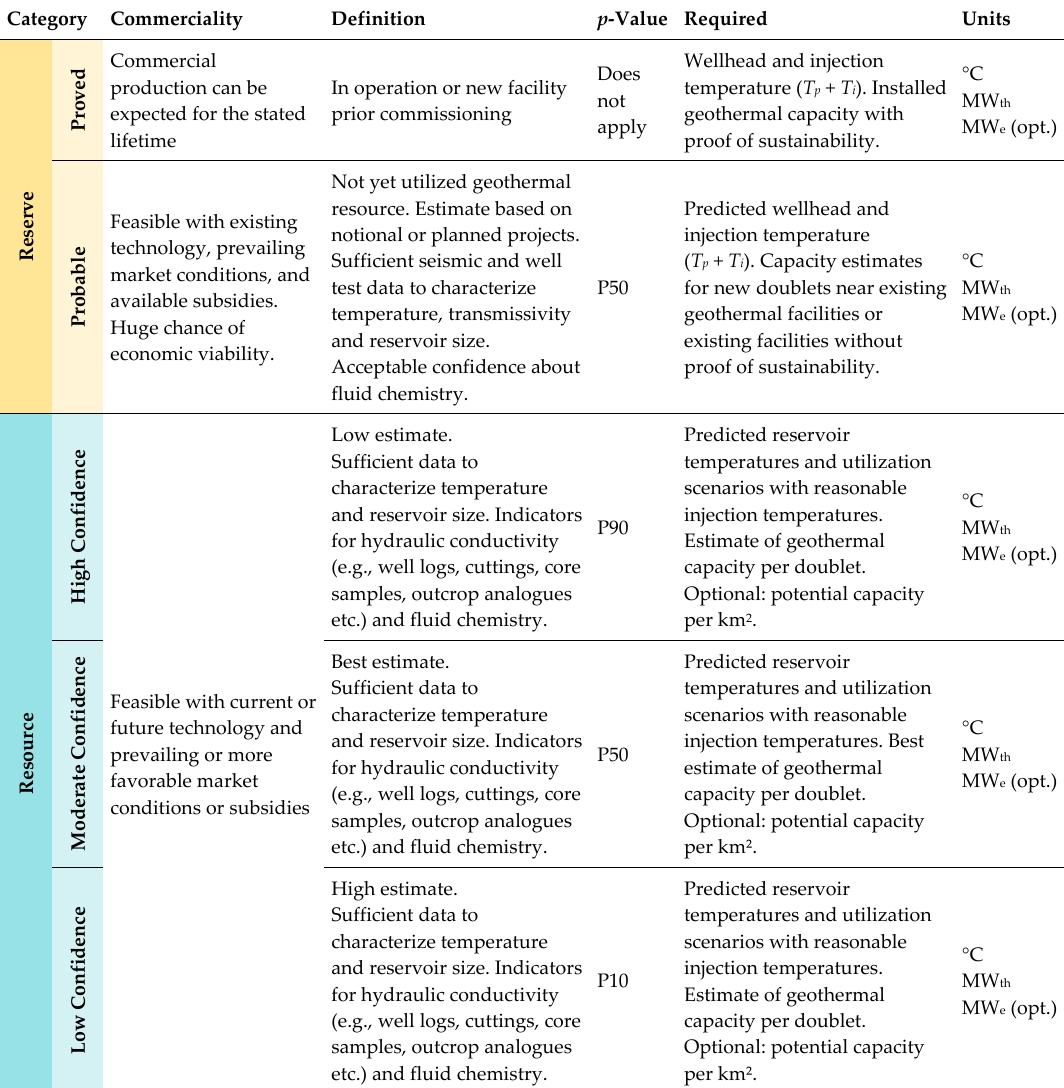
Table 4. Summary of capacity oriented resources and reserves classification.